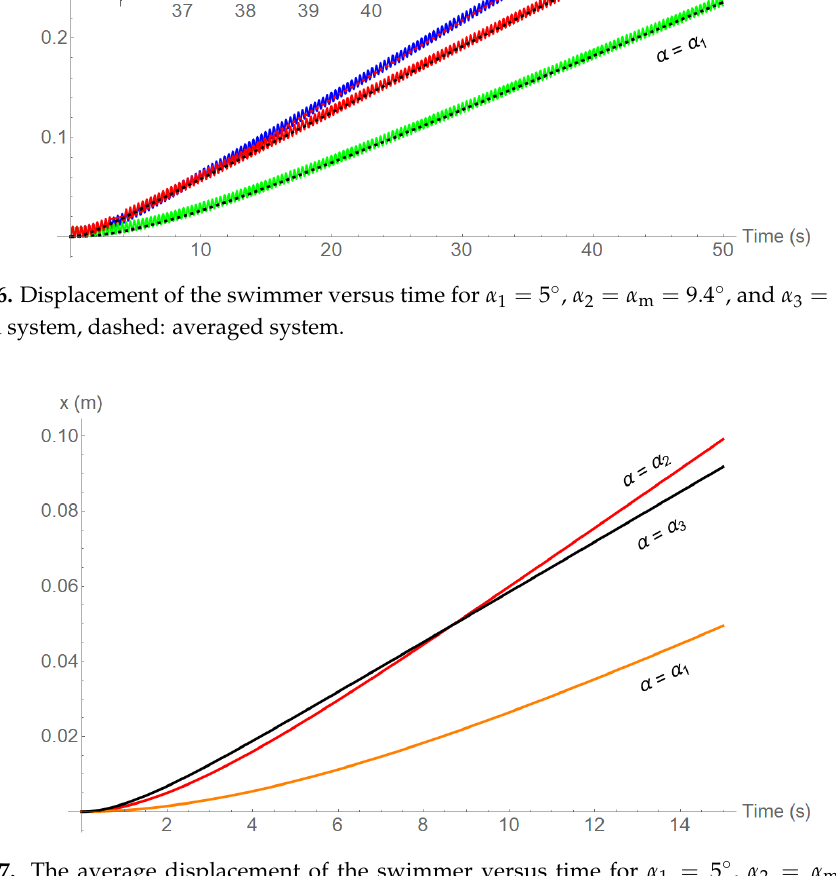
Figure 7. The average displacement of the swimmer versus time for α 1 = 5 ◦ , α 2 = α m = 9.4 ◦ , and α 3 = 15 ◦ during transient